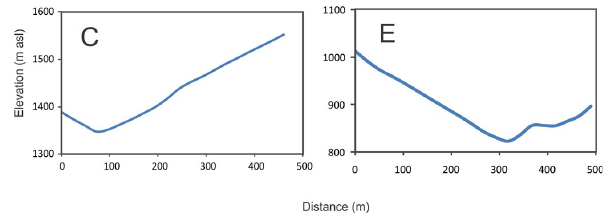
Fig. 10. Cross-sectional profiles from the upper bend (C) and the lower bend (E) used for velocity calculations in Fig.